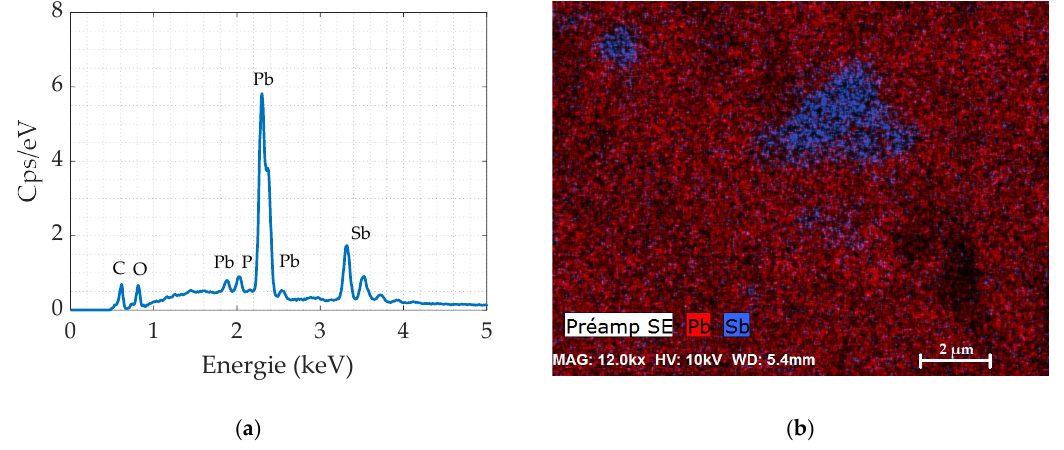
Figure 1. Energy-dispersive X-ray Spectroscopy (EDX) of the lead alloy: ( a ) EDX analysis; ( b ) EDX mapping.